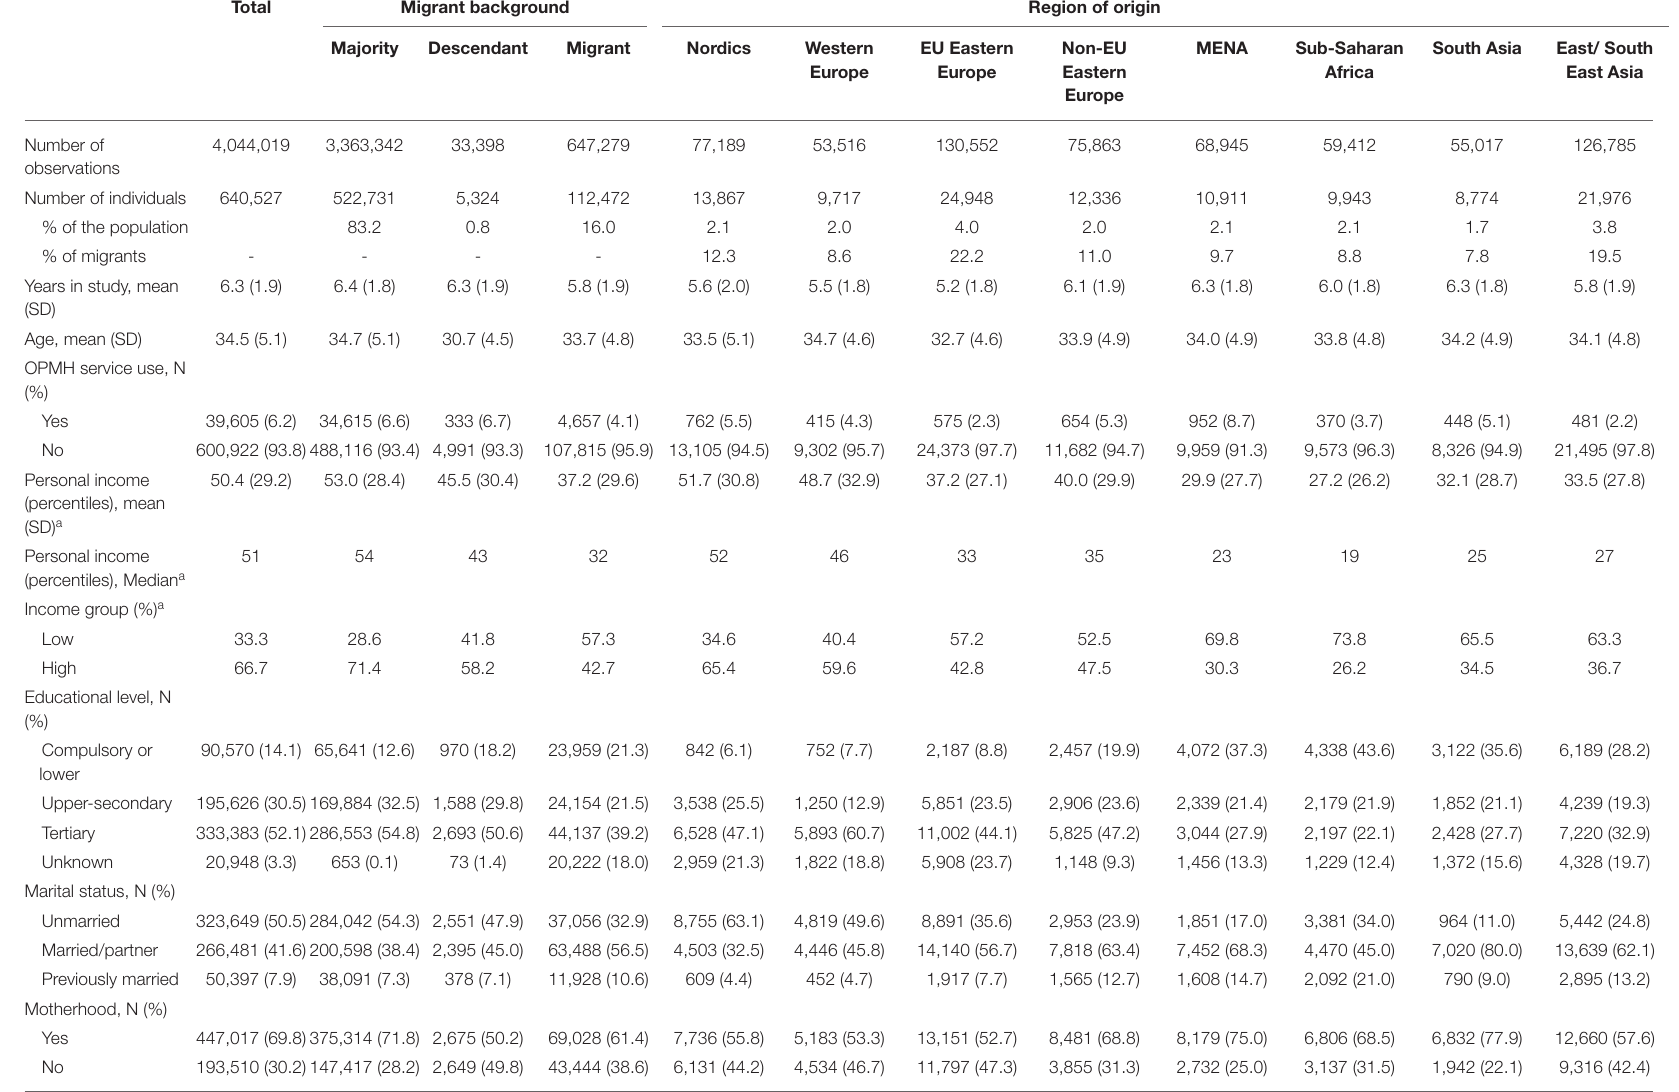
TABLE 1 | Characteristics of the study sample, by migrant background. Total Migrant background Region of origin Majority Descendant Migrant Nordics Western